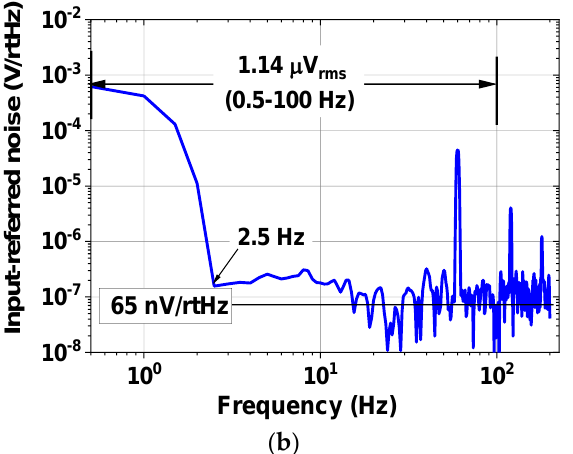
Figure 20. ( a ) Measured gain of the CCIA, ( b ) measured input-referred noise voltage spectral density of the CCIA for the active electrode.